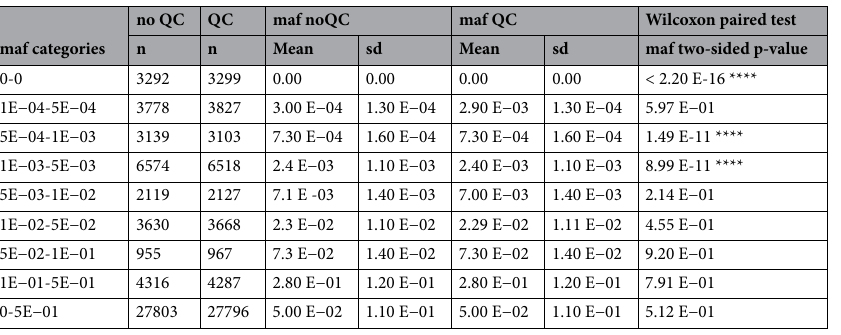
Table 1. Variants counts and Wilcoxon paired signed rank test of minor allele frequencies before and after QC. No significant differences were found in the total number (n) of variants before (no QC) and after QC (QC) with the Wilcoxon paired test (p value = 9.45 E−01) When stratifying each variant in the subclasses, significant differences in the maf were observed for the null alleles and one subclass of very rare (5E−04-1E−03) and rare variants (1E−03-5E−03). Levels of significance **** < 0.0001, *** < 0.001, ** < 0.01, * < 0.05. Percentage of SNPs with null MAF 12%, very rare MAF 24.8%, rare MAF 31.1%, low MAF 13.1%, common MAF 3.5%, SNP high MAF 15.5%. Percentage of rare variants < 0.01 is higher (68% including the null alleles and 56% without the null alleles) compared to the SNP MAF > 0.01 (32%). maf minor allele frequencies, n number of variants, sd standard deviation, QC quality